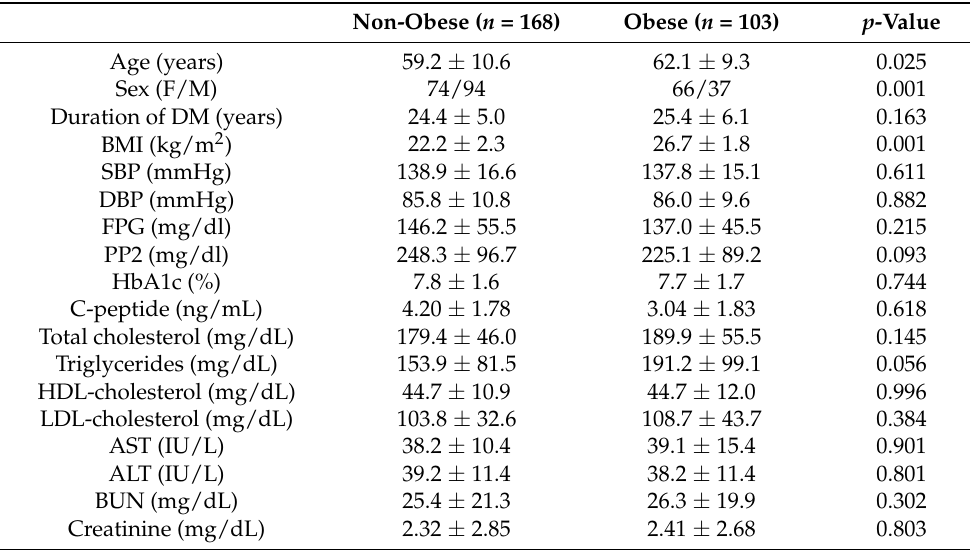
Table 1. Baseline characteristics of patients relative to BMI.